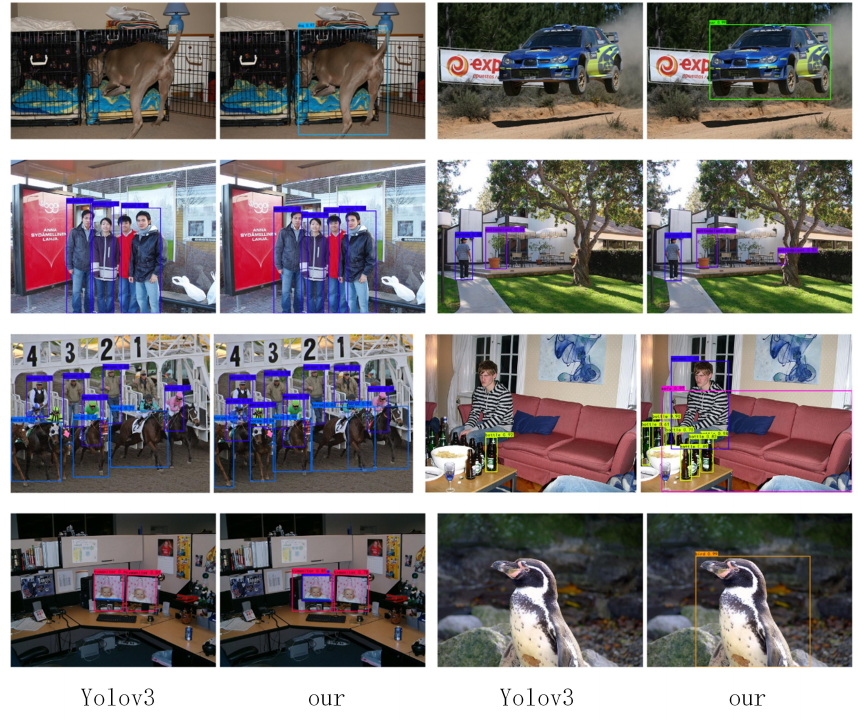
Figure 6. Comparison of visual experimental